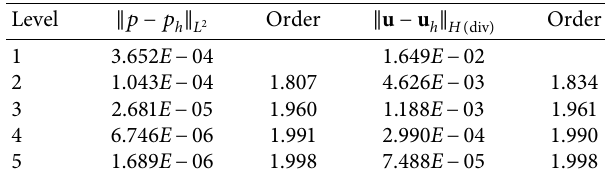
Table 1: L 2 -error for pressure and H ( div ) -error of velocity (Example 1).